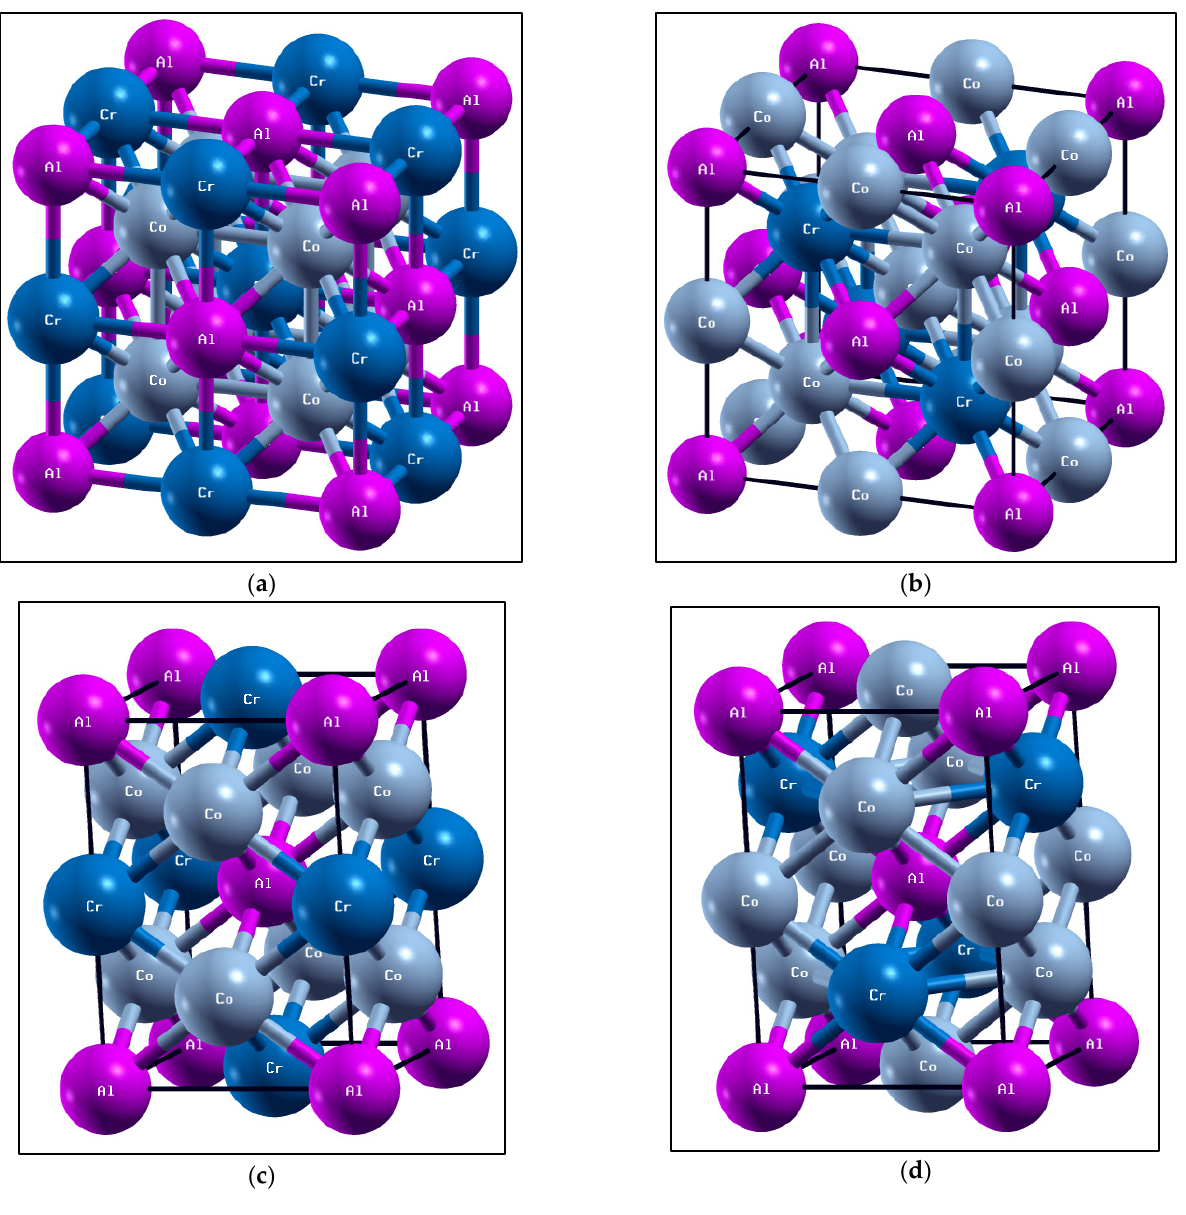
Figure 1. Different crystal structures of Heusler Co 2 CrAl. ( a ) Conventional Heusler structure Co 2 CrAl Fm-3m L21 (225), ( b ) inverse Heusler Co 2 CrAl structure F-43m X (216), ( c ) tetragonal structure I4/mmm (139) and ( d ) tetragonal structure I-4m2